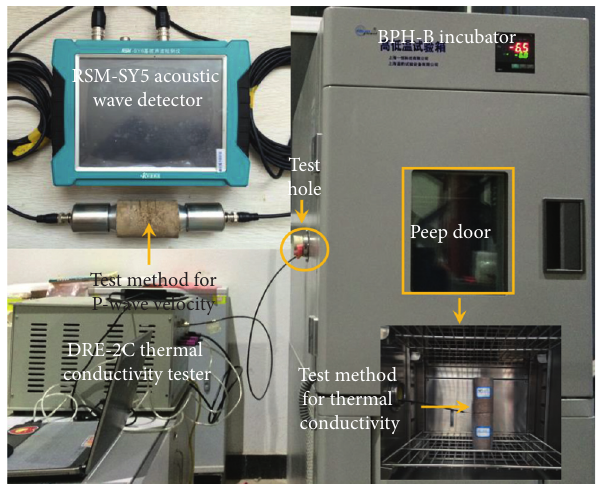
Figure 2: Plot of grain-size distribution.